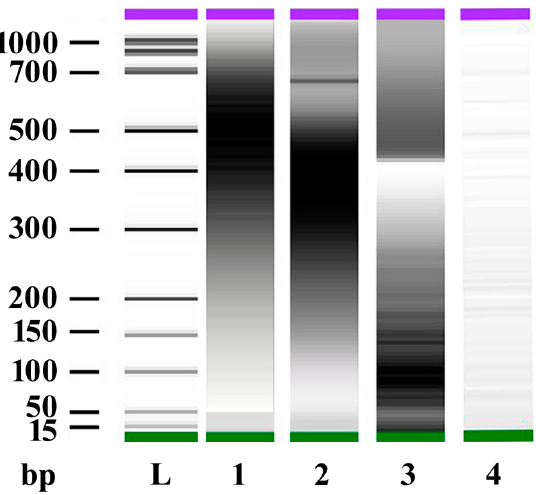
Figure 1. Bioanalyzer capillary gel electrophoresis densitometry plot from electropherograms of DNA fragments obtained by sonication of DNA extracts from Zea mays (lane 1), Phaseolus lunatus (lane 2), Spodoptera littoralis (lane 3), and S. littoralis oral secretions (lane 4). See Materials and Methods for more details. Z. mays and P. lunatus fragmented DNA are in the range between 300 and 700 bp. S. littoralis fragmented DNA is mainly composed of fragments between 15 and 300 bp, whereas S. littoralis oral secretions fragmented DNA shows small amounts of fragments throughout the bp range (this image has been digitally enhanced to visualize the bands). L, base pair ladder lane; bp, base pair size reference bars.